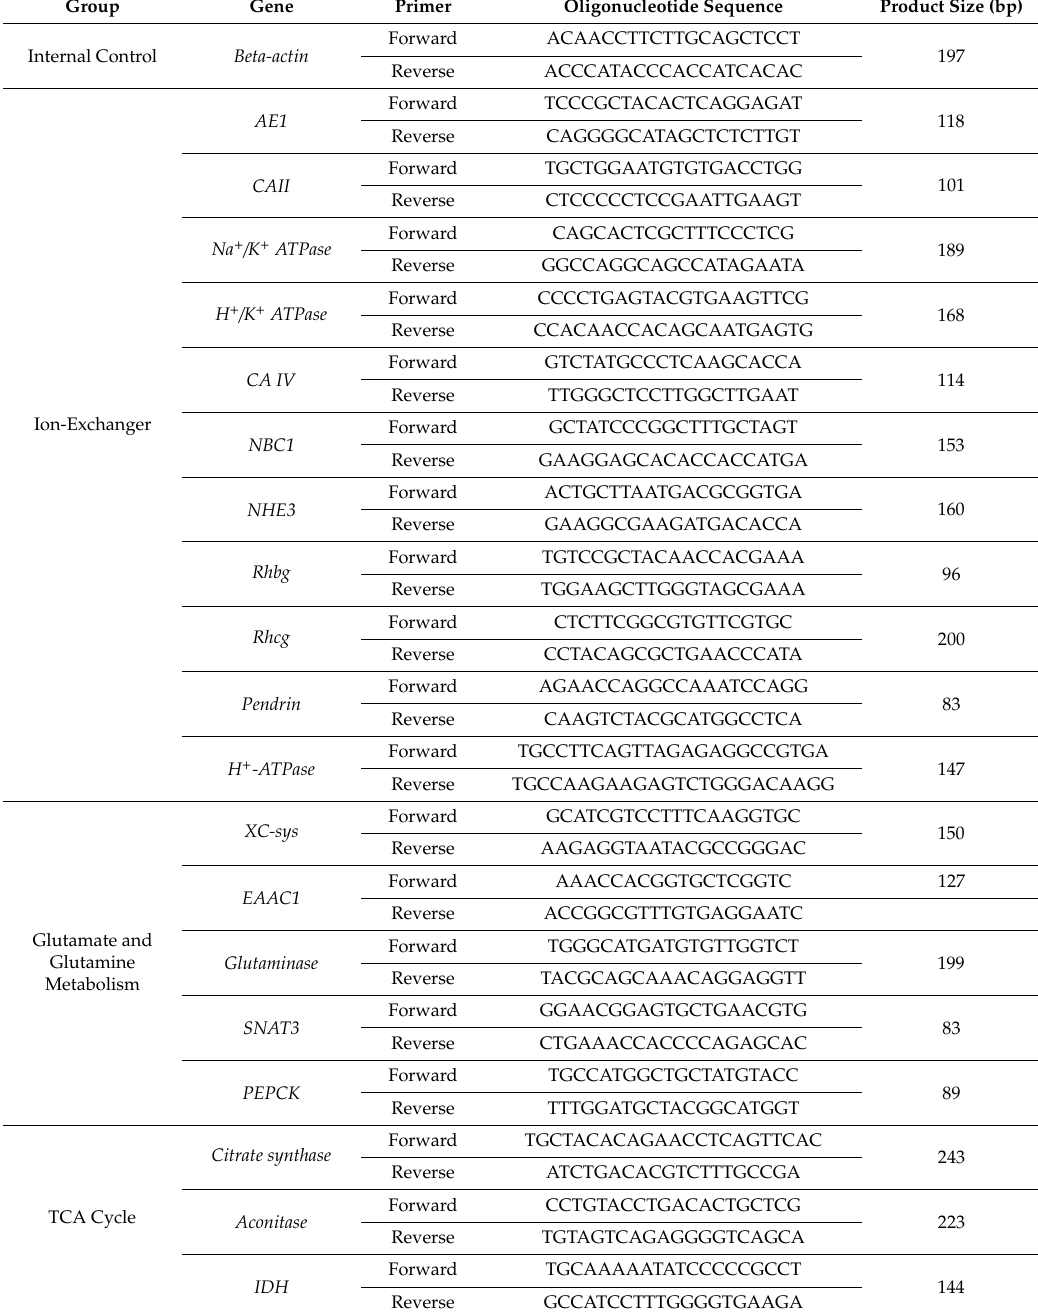
Table 1. Oligonucleotide primers used for gene expression